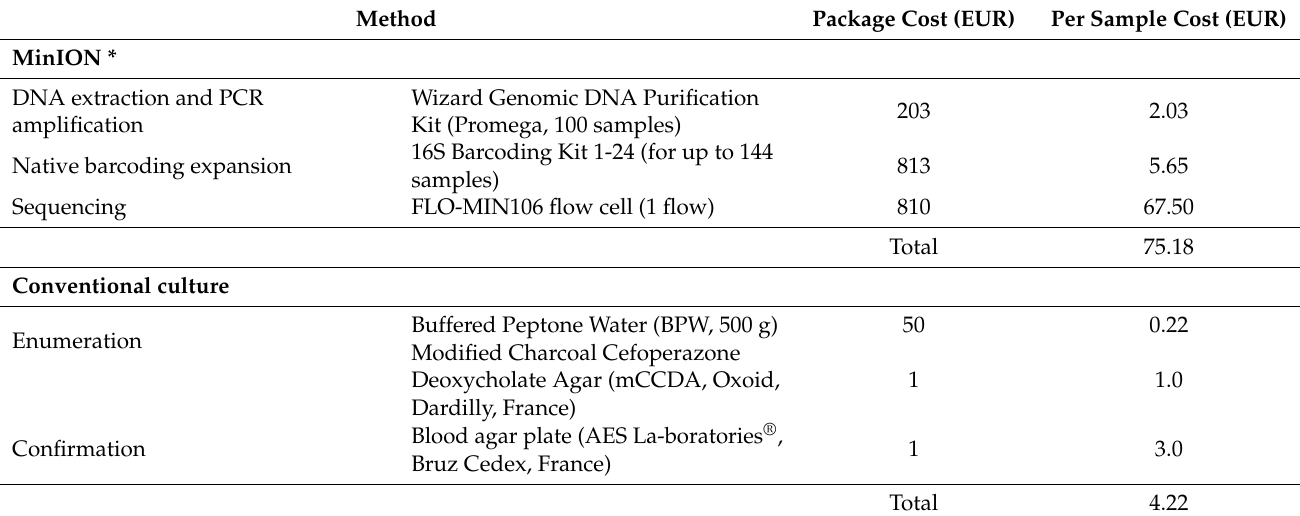
Table 4. Cost comparison between MinION sequencing and conventional culture for this study.